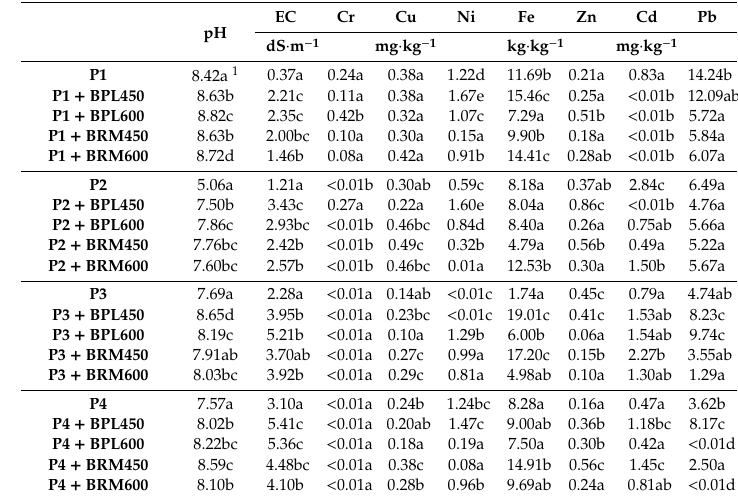
Table 5. pH, electrical conductivity (EC), and mobile metal content in control soils and biochar / soil mixtures from Portman area after 180 incubation